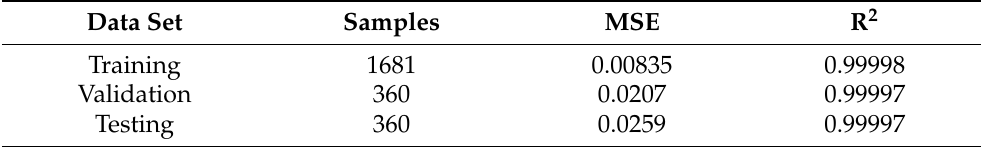
Table 3. NN performance for different data sets using 25 neurons in the hidden